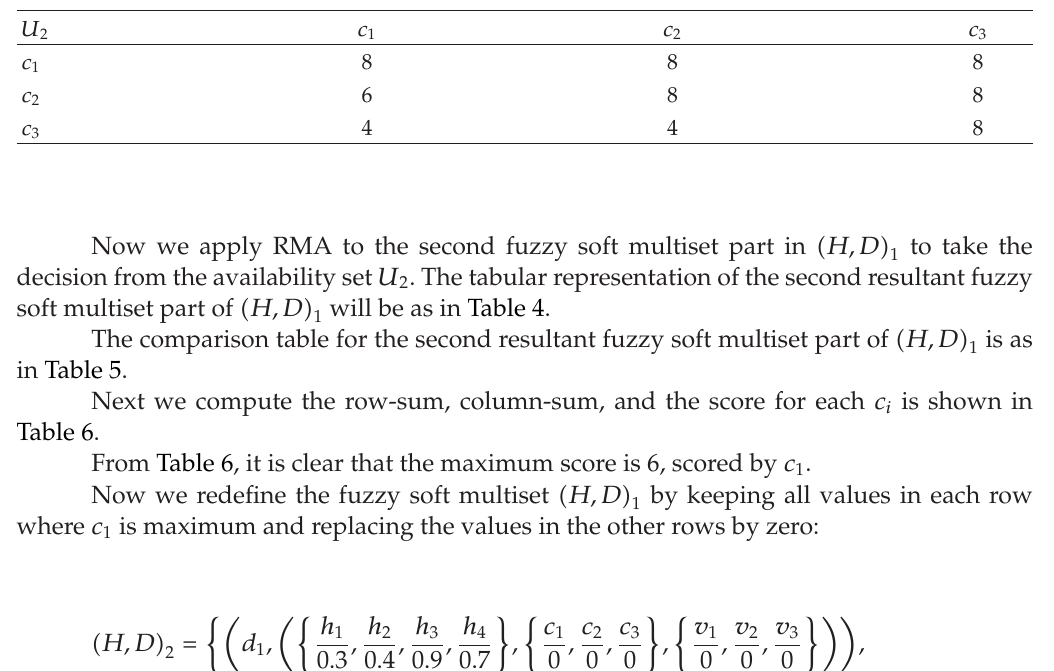
2 -fuzzy soft multiset part of